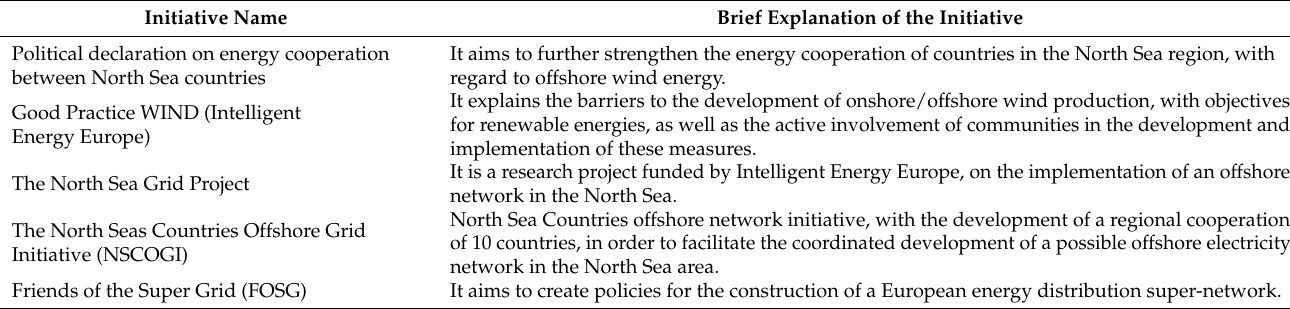
Table 4. Initiatives for the development of offshore wind